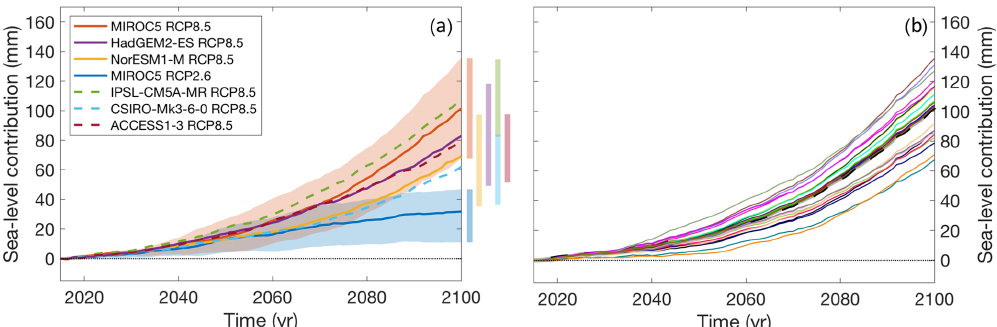
Figure 7. Ensemble sea-level projections. (a) ISM ensemble mean projections for the core experiments (solid) and extended experiments (dashed). The background shading gives the model spread for the two MIROC5 scenarios and is omitted for the other GCMs for clarity but indicated by the bars on the right-hand side. (b) Model specific results for MIROC5-RCP8.5. The colour scheme is the same as in previous figures. The dashed line is the result of applying the atmosphere and ocean forcing to the present-day ice sheet without any dynamical response